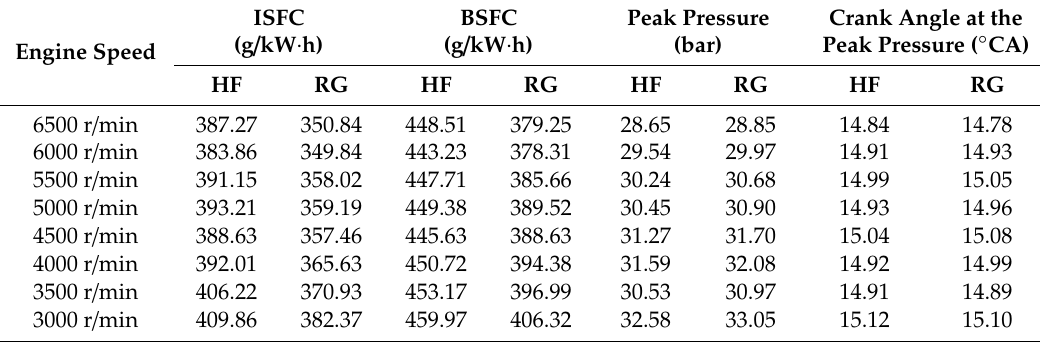
Table 18. Simulation results of engine speed characteristics (throttle valve opening = 100%).